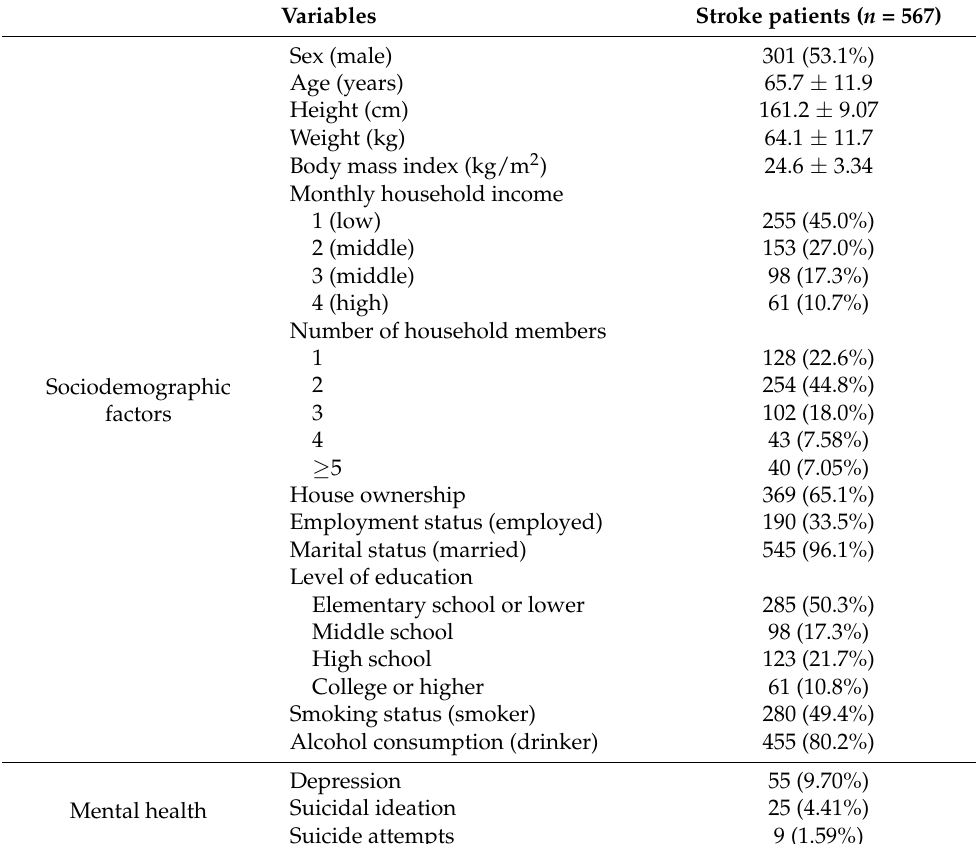
Table 1. General characteristics of the study subjects retrieved from the Korea National Health and Nutrition Examination Survey (KNHANES)